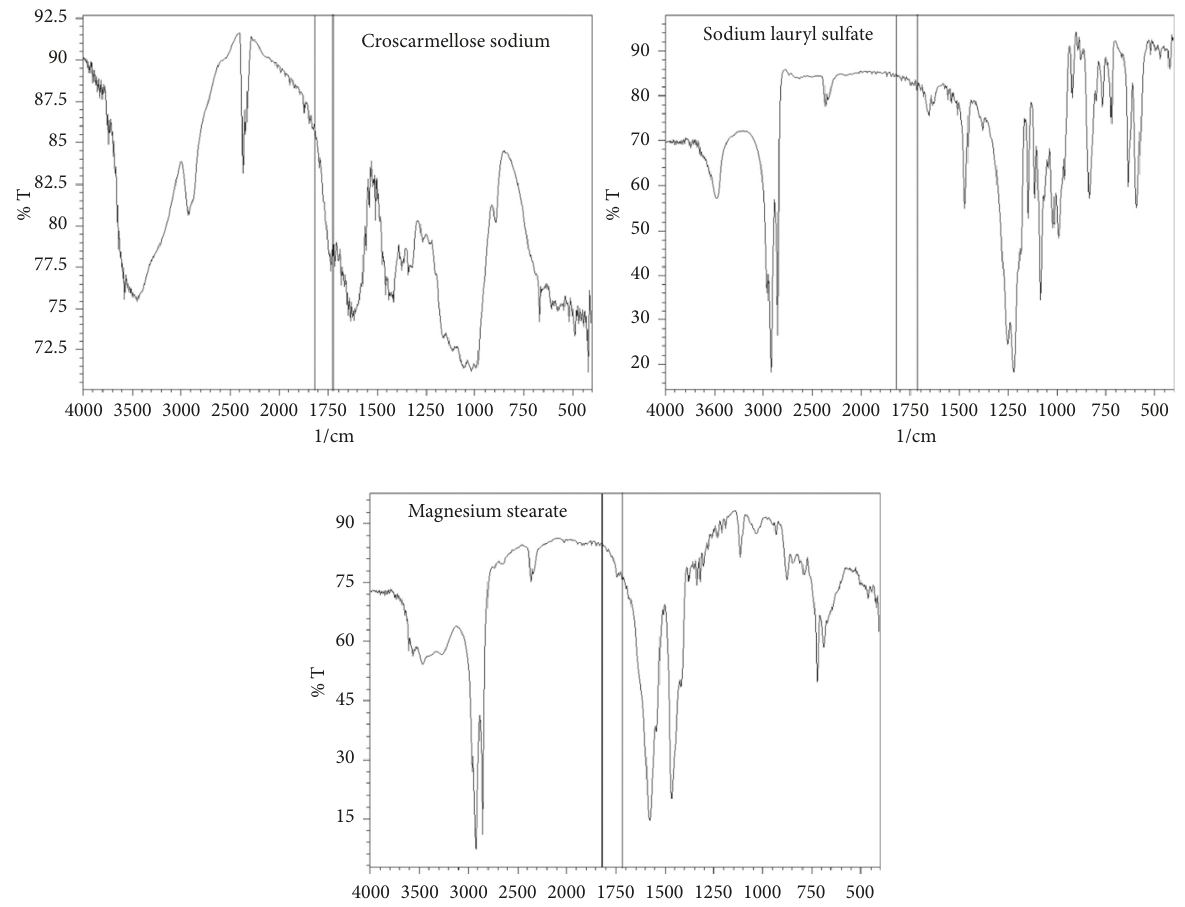
1 ) is highlighted. −